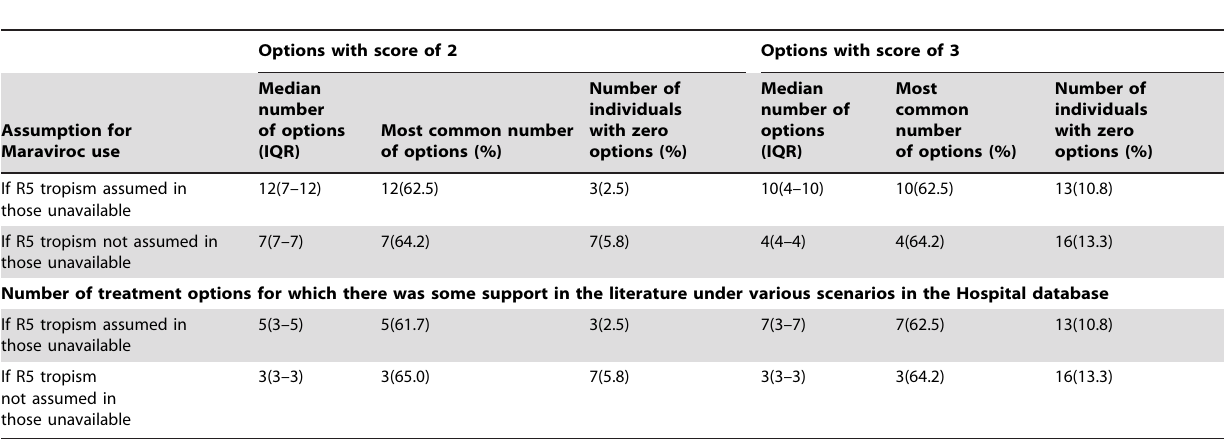
Table 2. Number of treatment options under various scenarios in the Hospital